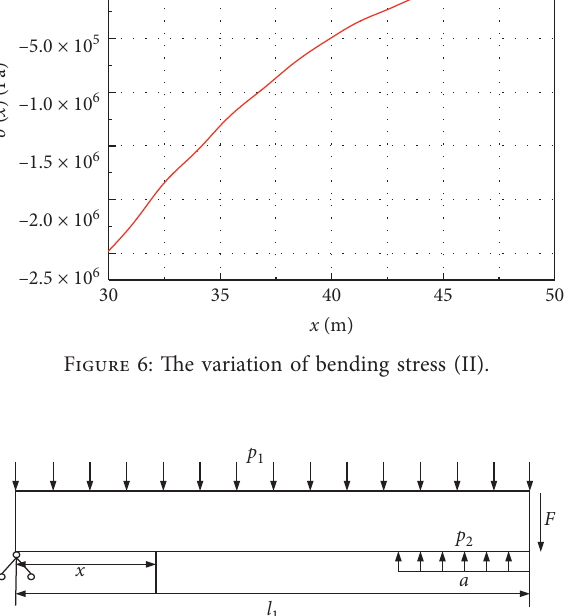
Figure 7: The mechanical model of forward direction fault (the periodical fracture).